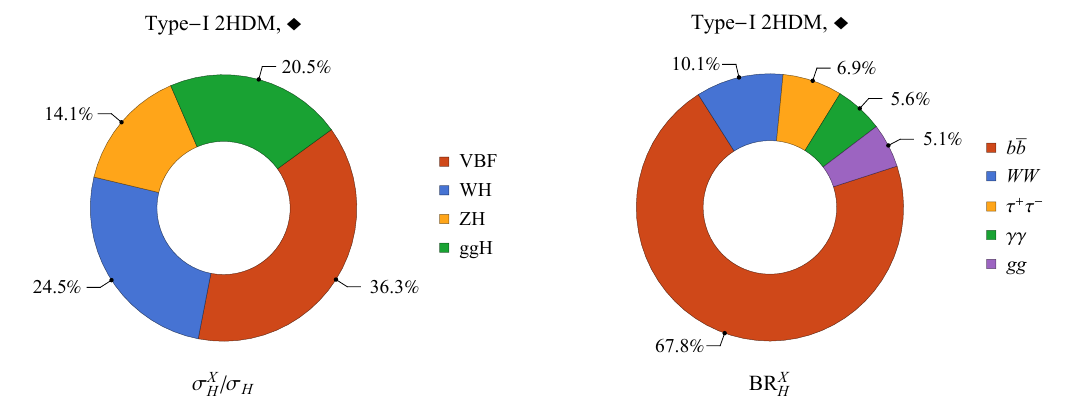
p s = 13 TeV. Right: =(cid:27) H and BR X values larger than 4% are depicted. The shown pie H H